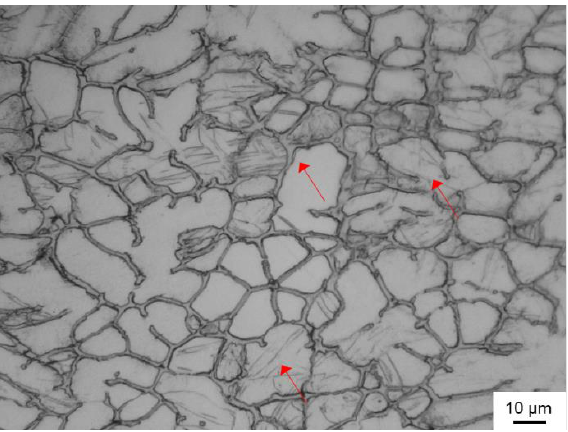
Figure 8. Optical micrograph of the WZ73 alloy in the twin-roll cast condition revealing twins in several adjacent grains of the magnesium matrix (red arrows).